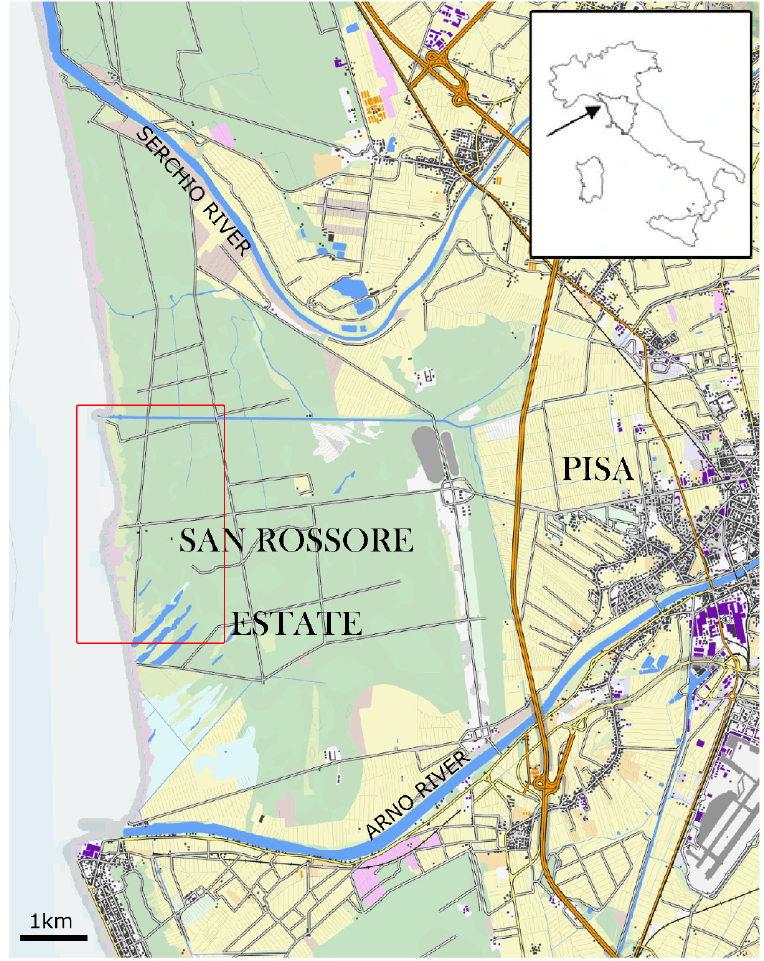
Figure 1. Map of the shoreline north of Pisa, showing the Regional Reserve of Migliarino, San Rossore, Massaciuccoli (Tuscany, Central Italy); the study area is delimitated in red.